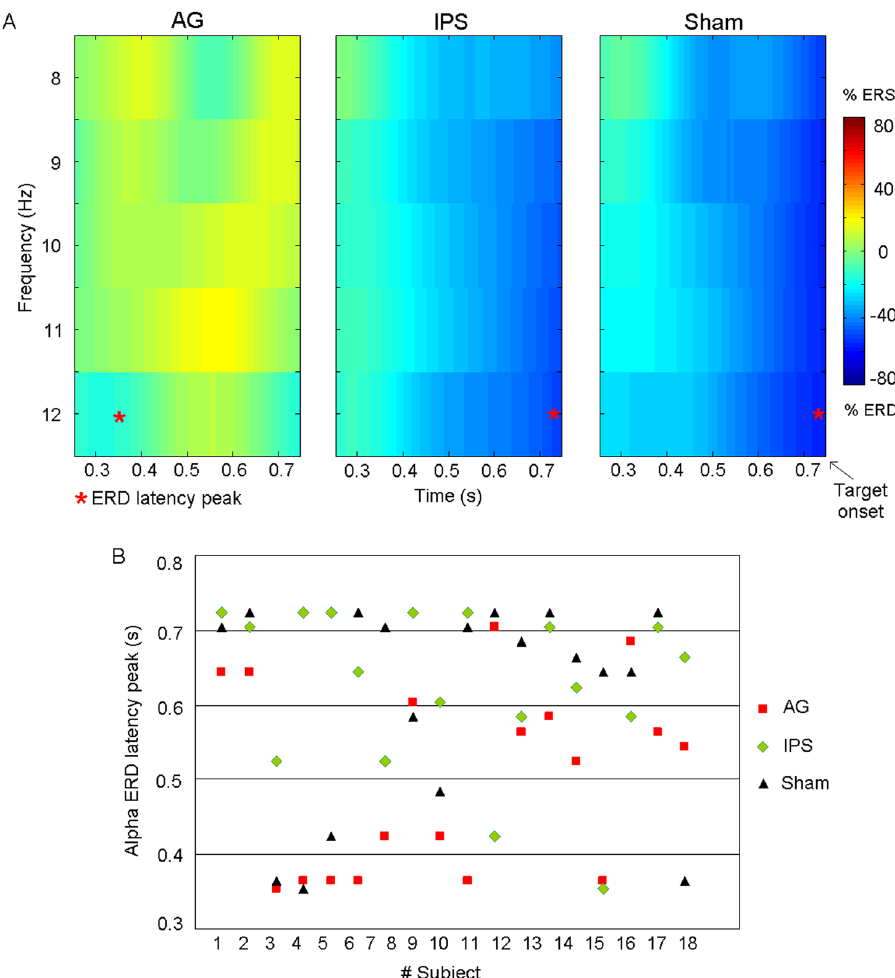
Figure 2. ( a ) Typical ERD time-frequency pattern for the frequency range between 8–12 Hz in the three TMS conditions (AG, IPS and Sham) from a representative subject in the period (i.e. 1 s) before the target onset. Notably, for each spectrogram the asterisk represents the ERD peak latency; ( b ) Individual alpha ERD peak latencies for each TMS conditions (AG, IPS and Sham). In the majority of subjects the alpha ERD peak latency was shorter after magnetic stimulation of AG compared to both Sham and IPS conditions.